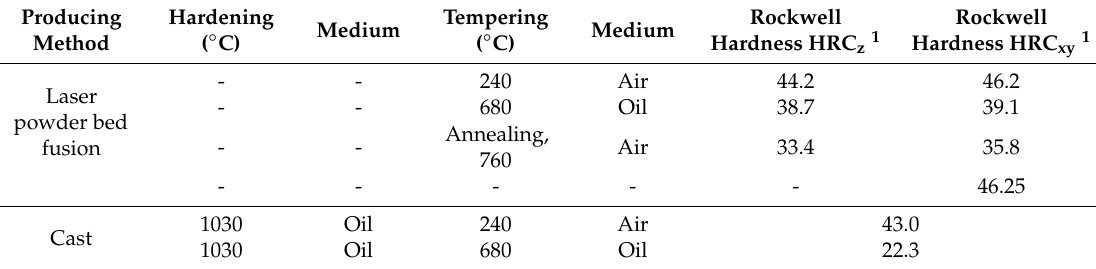
Figure 15. Histogram of volumetric losses during abrasive wear of steel 20kH13 (AISI 420), 9 min of wear time. Table 7. Rockwell hardness of the samples made of the 20kH13 (AISI 420) steel in raw state after various types of post-processing.